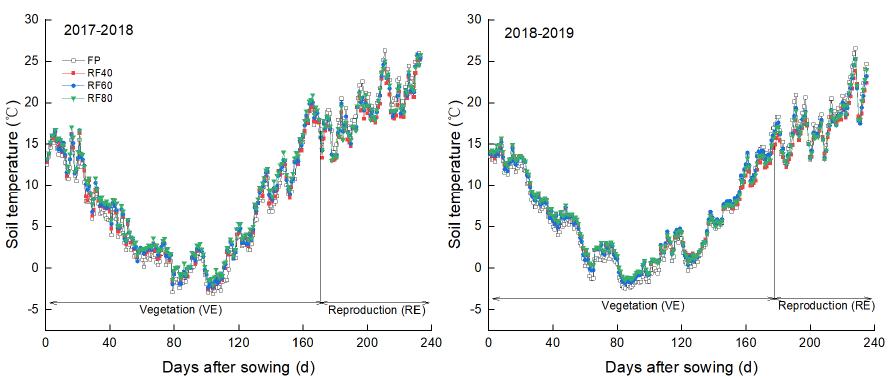
Figure A1. Seasonal variations of soil temperature at 5 cm soil depths in different planting patterns in 2017–2019.